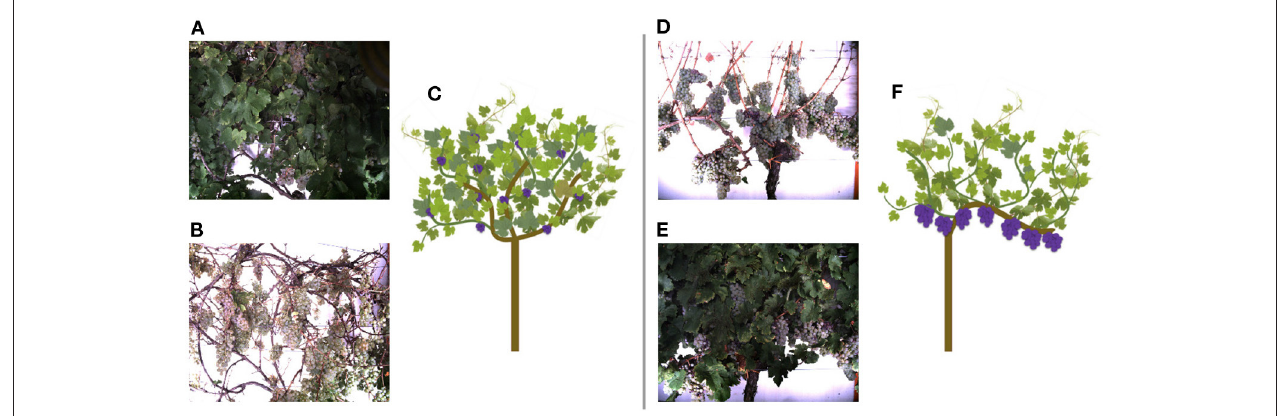
FIGURE 3 | Acquired images of the Phenoliner (Kicherer et al., 2017) for two different kind of cuttings: semi minimal pruned hedge SMPH (A–C) and vertical shoot positioned system VSP (D–F) . (A,D) Show example images before defoliation in the occluded domain. (B,E) Show example images after defoliation in the non-occluded